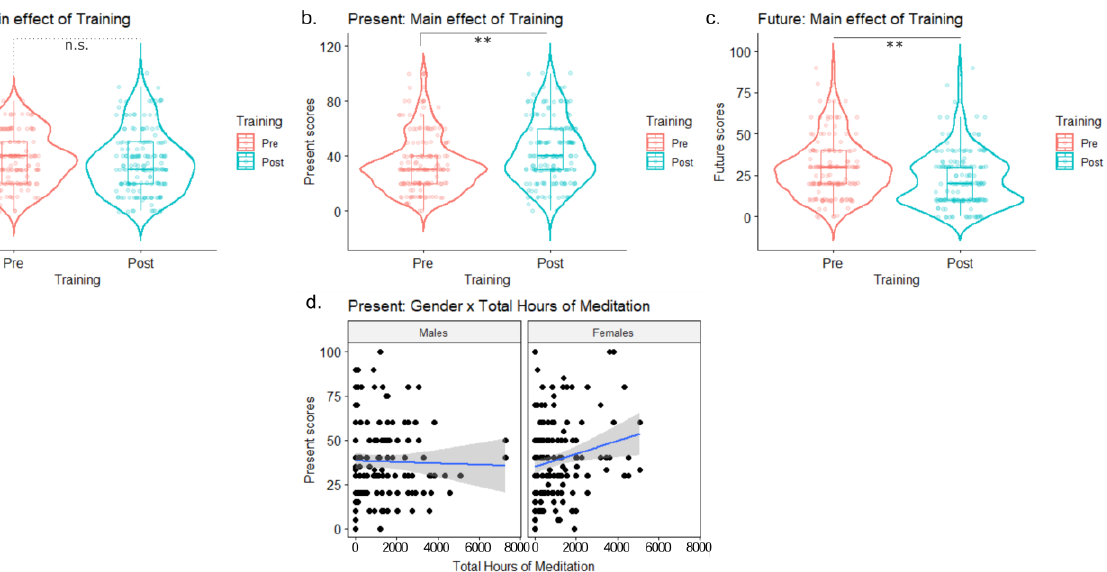
Figure 5. ( a ) Main effect of training (pre vs. post) on past time perspective scores. ( b ) Main effect of training (pre vs. post) on present time perspective scores. ( c ) Main effect of training (pre vs. post) on future time perspective scores. ( d ) Plot of the sex x total hours of meditation interaction on present time perspective scores. Significance levels: ** = p < 0.01; n.s. = p > 0.05.